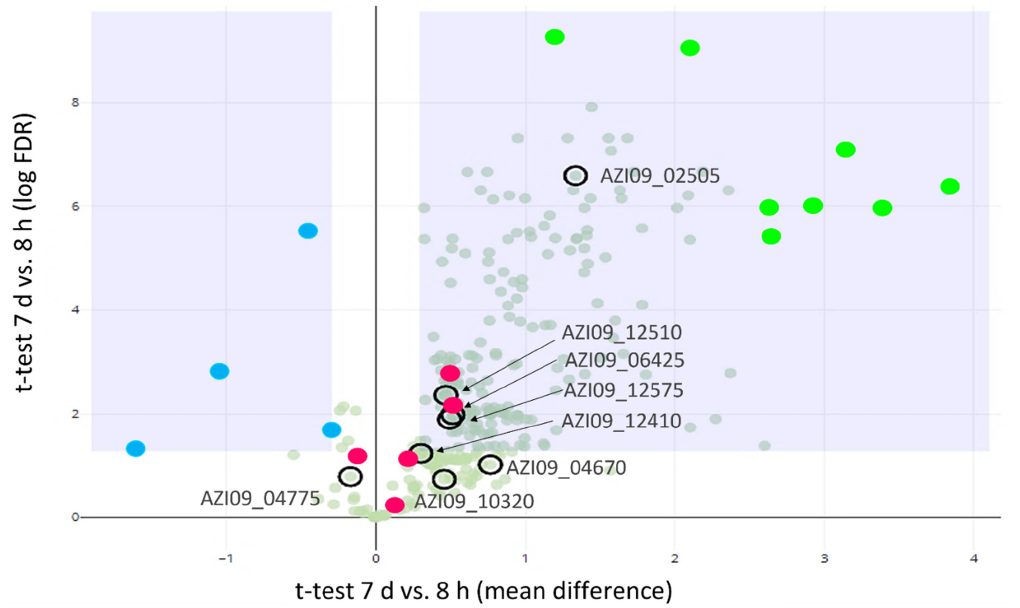
Figure 3. Proteomics analysis of secreted proteins. Volcano plot for the differential abundance analysis of 8 h vs. 7 d secretomes: GHs and GTs ( encircled ), proteins with higher abundance at 8 h ( blue dots ), proteins with higher abundance at 7 days ( light green dots ), and potential moonlighting proteins ( red dots ).